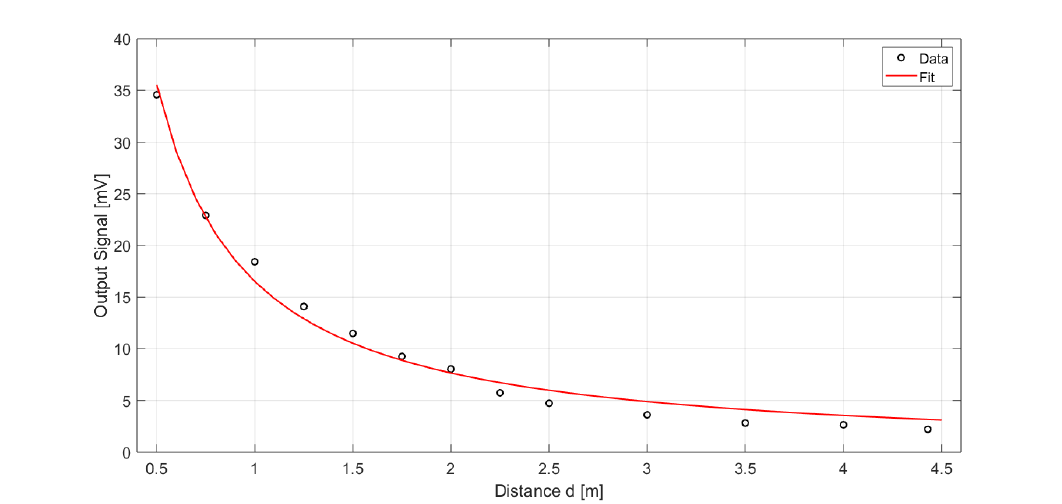
Figure 16. Graphical comparison between the derived fit and the measured data in the case of 6.5 ◦ fixed angle.